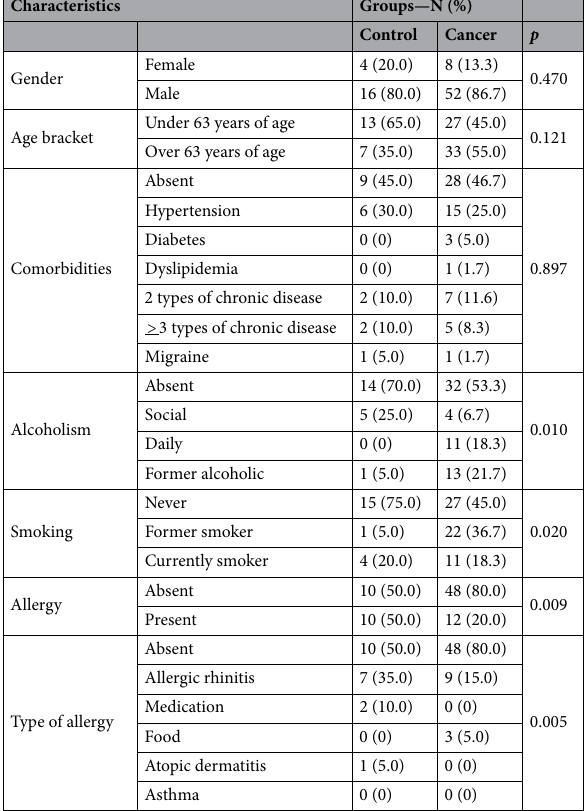
Table 1. Characterization of the studied sample. Pearson’s chi-squared test. N =